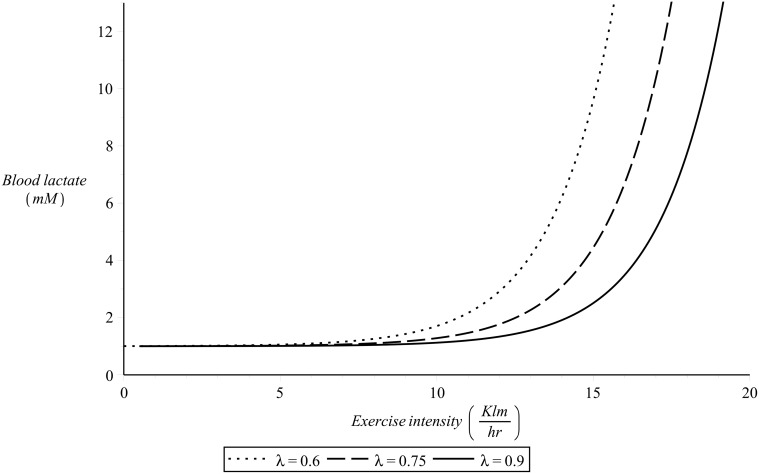

L
λ,v(λ,v) as defined in Equation (14) for different values of λ.For the numerical simulations there was α
6 = 0.5 hr/Km and vmax(λ)=20λ (Km/hr).